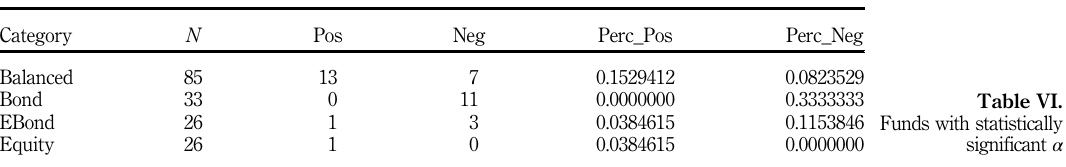
multi-factor regression